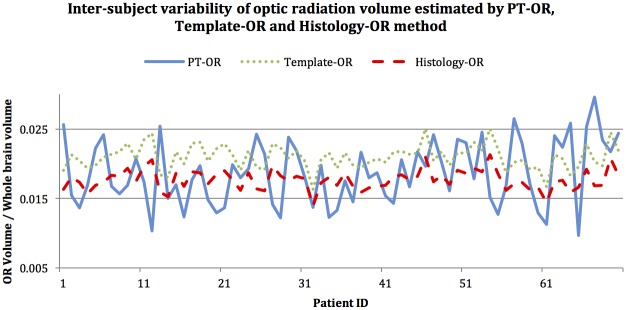
Inter-subject variability of OR volume estimated by PT-OR (blue), template-OR (Green) and Histology-OR.